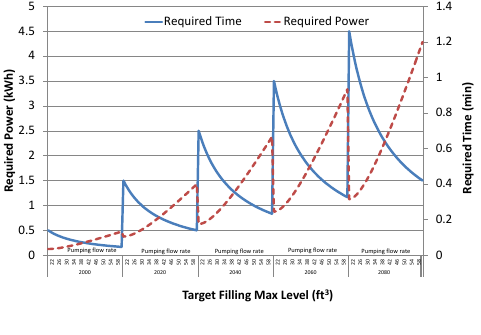
Figure 5. Required pumping duration and respective energy consumption for tank current water level as 1990 ft 3 and varying target Max level from 2000 to 2080 ft 3 .